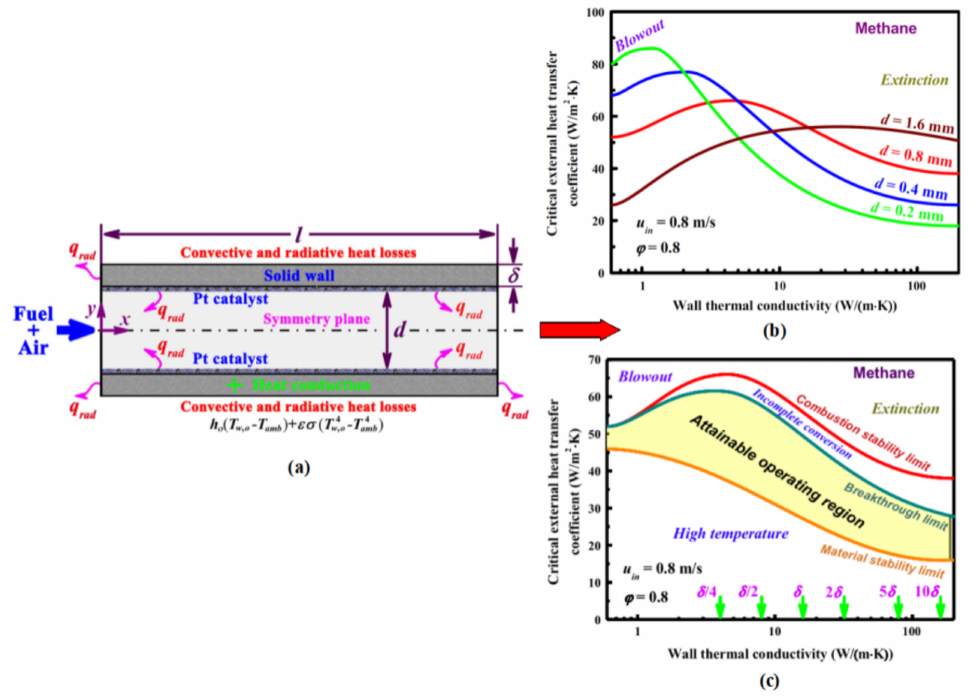
Figure 8. Stability diagram in terms at different inlet velocities. ( a ) Catalytic single channel, ( b ) Com- bustion stability for different diameters, ( c ) Combustion stability for different wall thermal